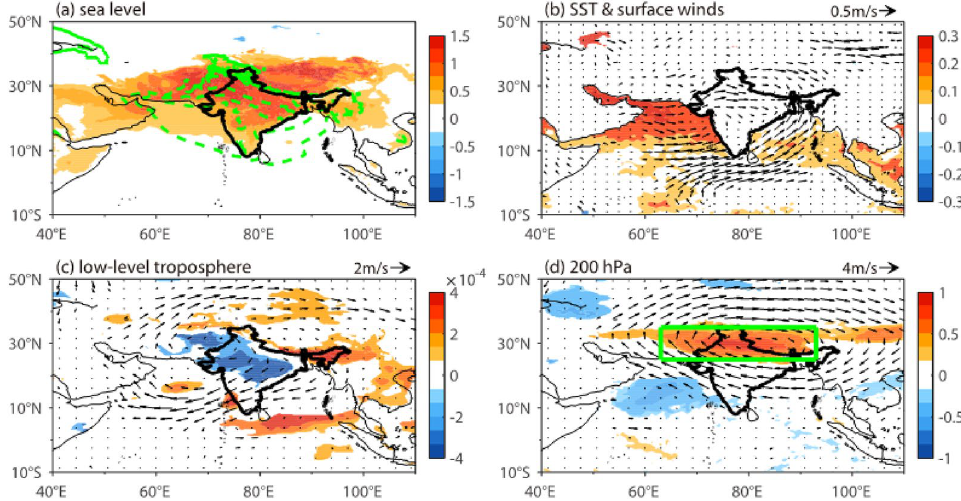
Fig. 3 Regressions of the PC1 with a SAT (colors; °C), sea level pressure (contours; hPa), b sea surface temperature (SST; colors; °C) and surface winds (vectors; m/s) for the period of 1979–2022. c Is the same as b , but for winds (vectors; m/s) at 700 hPa and the specific humidity (colors; g kg − 1 ) integral from 850 to 700 hPa. d Is the same as b , but for the vorticity (colors; 10 5 s − 1 ) and winds (vectors; m/s) at 200 hPa. The green box marks the × region from 25°N to 35°N and from 63°E to 93°E, which is used to define the anti-cyclone index (ACI). Only anomalies which are significant at 95% significance level are